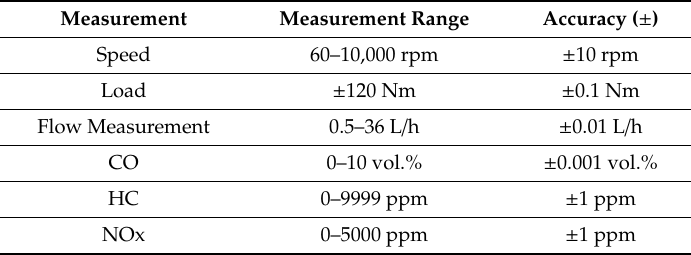
Figure 2. Schematic view of diesel engine set-up.